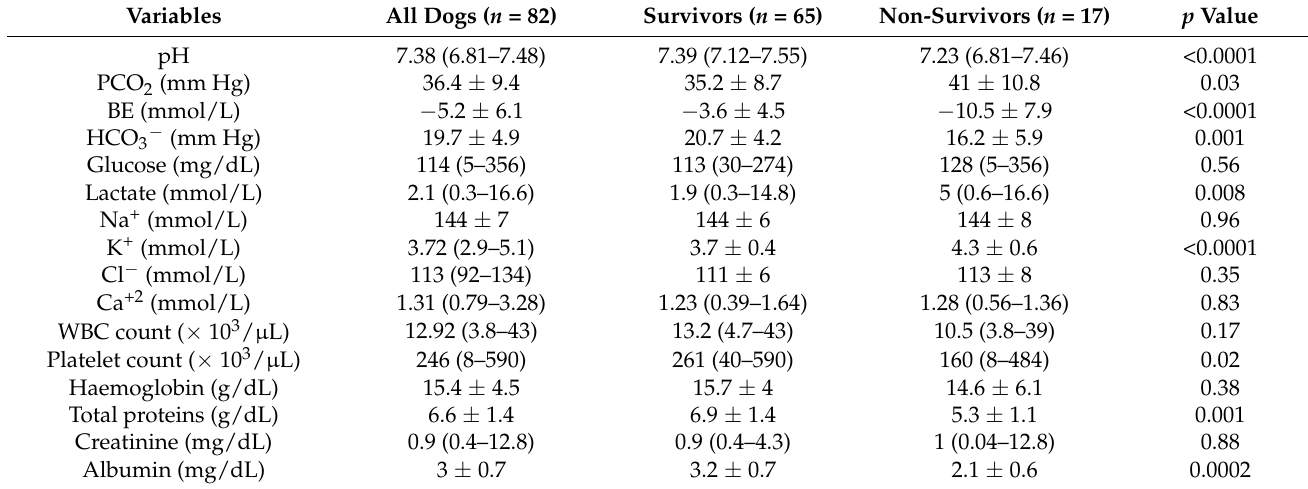
Table 4. Laboratory values at admission of the complete cases and divided on the basis of the outcome (survivors and